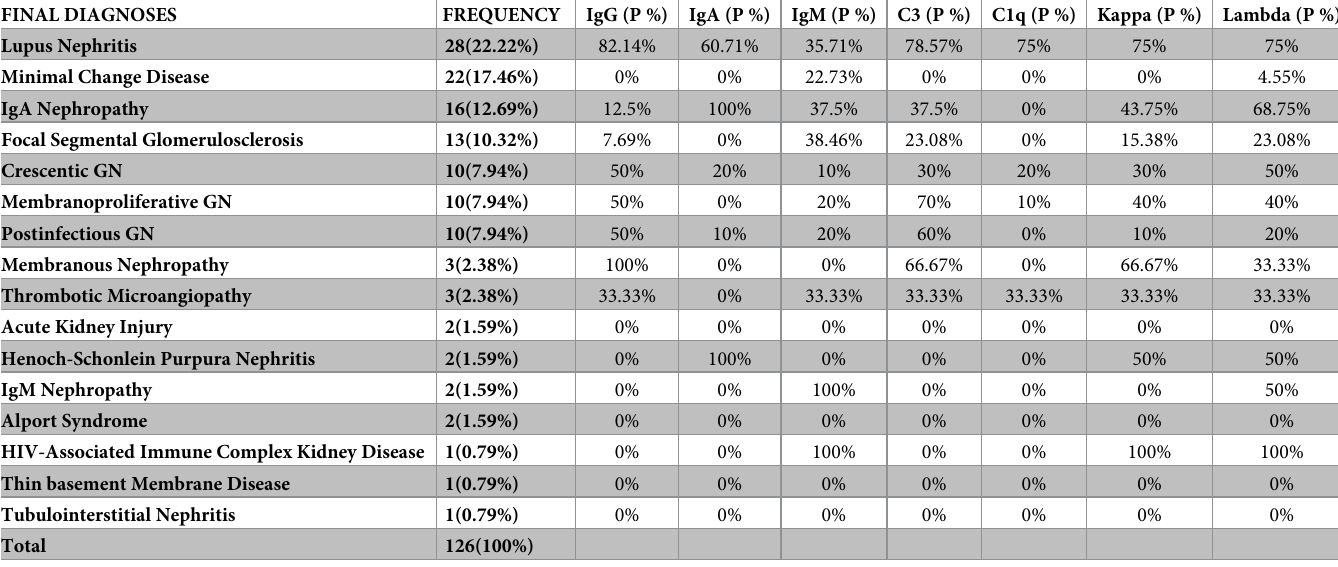
Table 4. Frequency of positivity of immunoglobulins in different kidney diseases (N = 126). FINAL